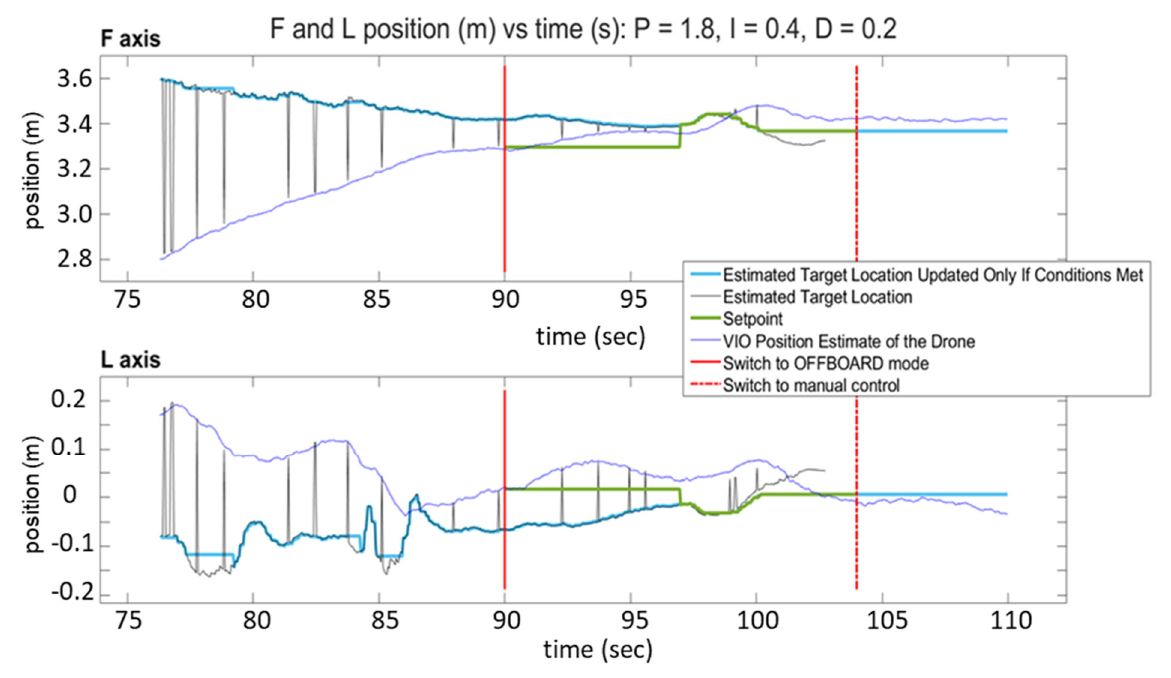
Figure 13. SVGS automated landing experiment 1: position vs. time for F and L axes.